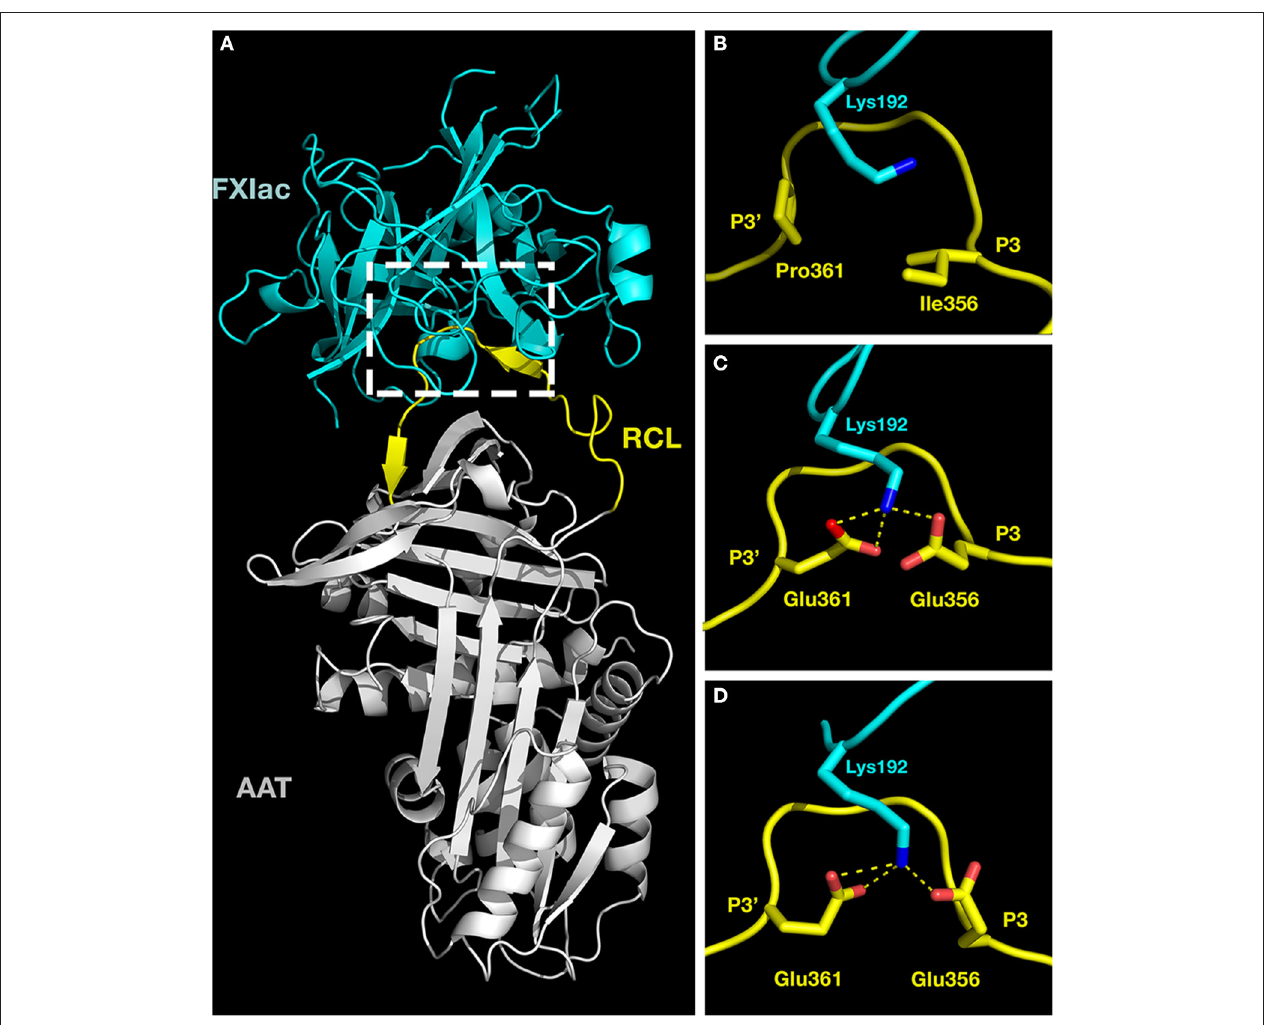
FIGURE 5 | Molecular models of activated factor XI docked to AAT variants. Crystal structures of the catalytic domain of FXIa (FXIac, cyan, PDB 1ZNT) and AAT M358R (PDB 1OPH, RCL yellow, rest of AAT gray) were docked using ClusPro 2.0 as described in the METHODS section. (A) The full structure of the docked proteins. (B–D) Exploded close-ups of the AAT RCL and the active site of FXIac [corresponding to the white dashed box in (A) ] for AAT M358R (B) , AAT-RC (C) , and AAT-RC-2 (D) . Yellow dashed lines indicate hydrogen bonds predicted to form between FXIac K192 nitrogen atoms (blue) and Glu 356 and Glu 361 oxygen atoms (red) in AAT-RC and AAT-RC-2 (B,C) but not in AAT M358R (A) . More remote portions of the FXIac chain were deliberately reduced in visibility using PyMOL in order to maximize the visibility of K192 of FXIac and the AAT RCL between P3 and P3’ in (B–D)